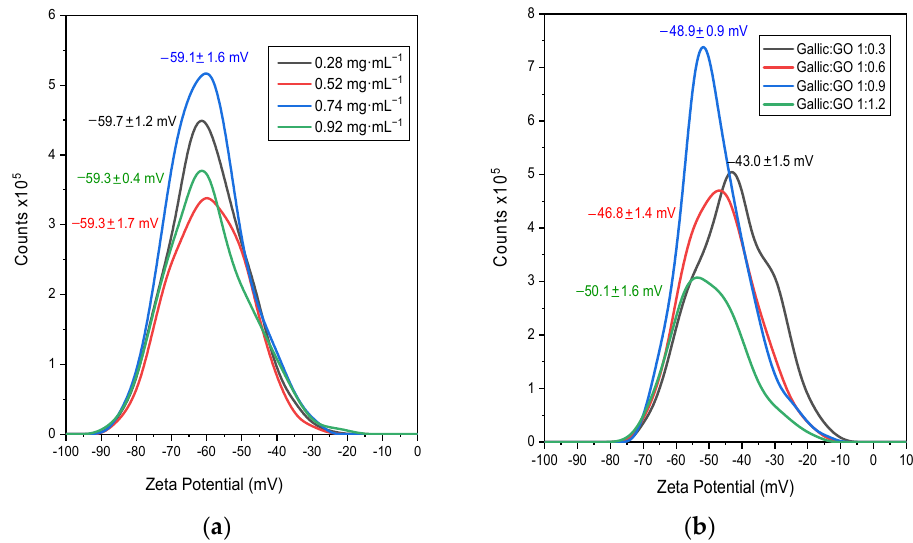
Figure 2. Zeta-potential distributions of GO in ( a ) aqueous solutions and ( b ) aqueous gallic acid solutions. The concentrations correspond to the amount of GO in the RC/GO formulations studied.